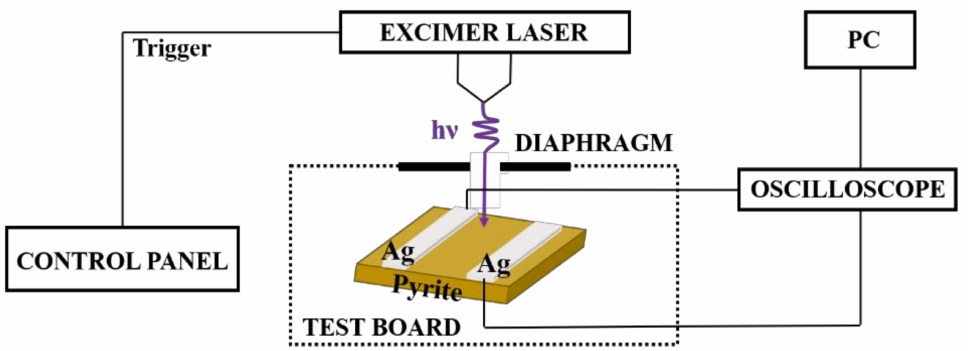
Figure 2. The schematic diagram of the measurement